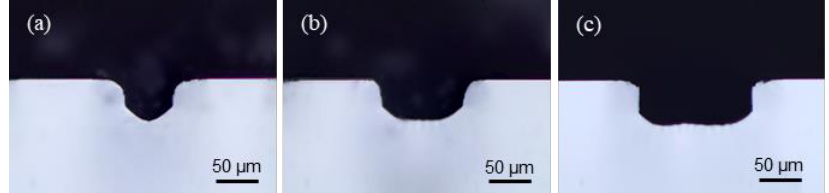
Figure 7. Optical images of fabricated channels from the section views at widths of ( a ) 50 µm, ( b ) 100 µm, and ( c ) 150 µm. Depths are 50 µm.